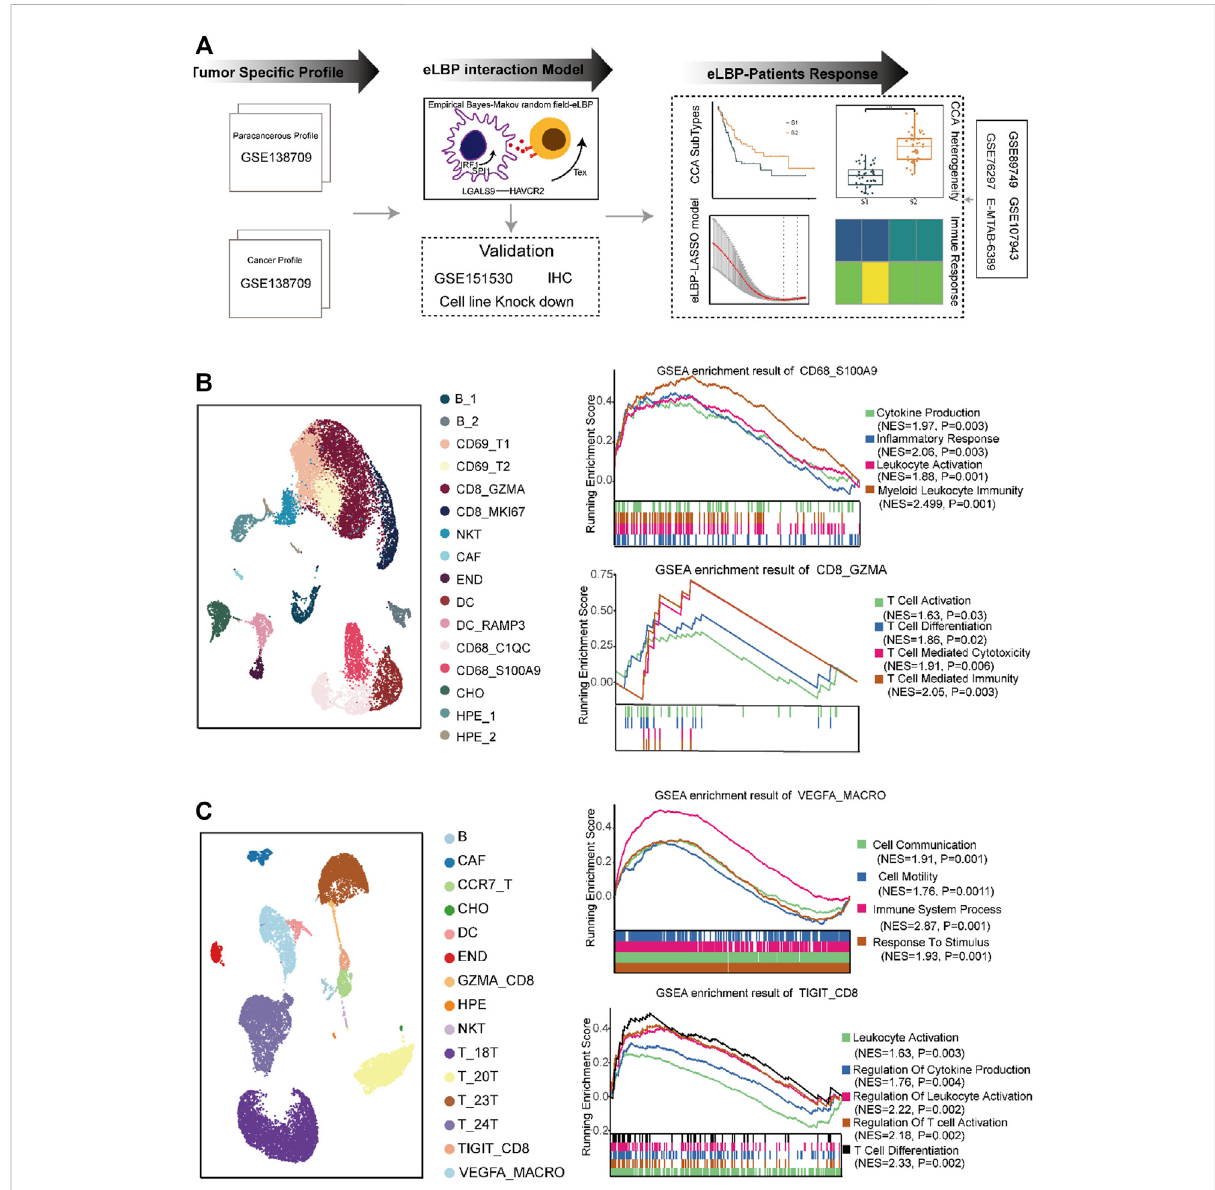
FIGURE 1 The distinct composition and function of cell types in the tumor microenvironment of cholangiocarcinoma. (A) Overview of the study design. We fi rst analyzed distinct cell composition and function of the normal and cancer tissue in cholangiocarcinoma (CCA) single-cell RNAseq dataset (GSE138709). Next, we developed a method integrating empirical Bayes and Markov random fi eld models (eLBP) which could simultaneously calculate transcription factors, interaction genes, and associated signaling pathways involved in cell-cell communication. We found that TFs IRF1/SPI1 in VEGFA -positive macrophages could enhance the expression of LGALS9 and induce the exhaustion of CD8 T cells via LGALS9/HAVCR2 axis by eLBP method. Meanwhile, we obtained 54 genes involved in cell communication. The 54-gene panel could also group the CCA patients into two subtypes, in which patients in S2 showed high expression level of immune related genes and had better prognosis. Finally, we constructed a nine-geneeLBP-LASSO-COX riskmodelwhich wasdesignated astumor microenvironmentriskscore (TMRS). TheTMRSpanel wasrevealedto bea reliable tool for prognostic prediction and chemotherapeutic decision-making in CCA. (B) Uniform manifold approximation and projection (UMAP) plot showing the cell composition in normal. GSEA enrichment plot showing the function of macrophage subtypes CD68_S100A9 and CD8 T cell subtypeCD8_GZMA.NES:Normalizedenrichmentscore. (C) UAMPplotshowingthecellcompositionincancer.GSEAenrichmentplotshowingthe function of macrophage subtypes VEGFA_MACRO and CD8 T cell subtype TIGIT_CD8. NES: Normalized enrichment